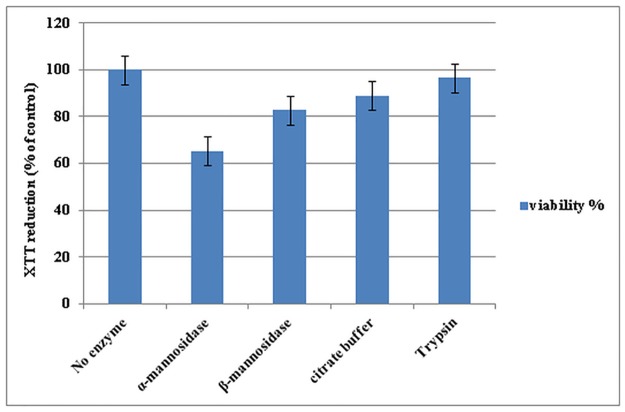
Influence of the most effective concentrations of alpha-mannosidase (0.02 unit/ml), beta-mannosidase (0.02 unit/ml), citrate buffer (100mM, pH 4.5) and trypsin (0.75μg/ml) on the viability of A-431 human epidermoid carcinoma cell lines after 24h incubation.No enzyme column represents control positive of the test. The relative cell viability (%) was computed by this formula: [A]test/ [A]control ×100. The experiment was performed 2 times in duplicates. Error bars represent standard errors.